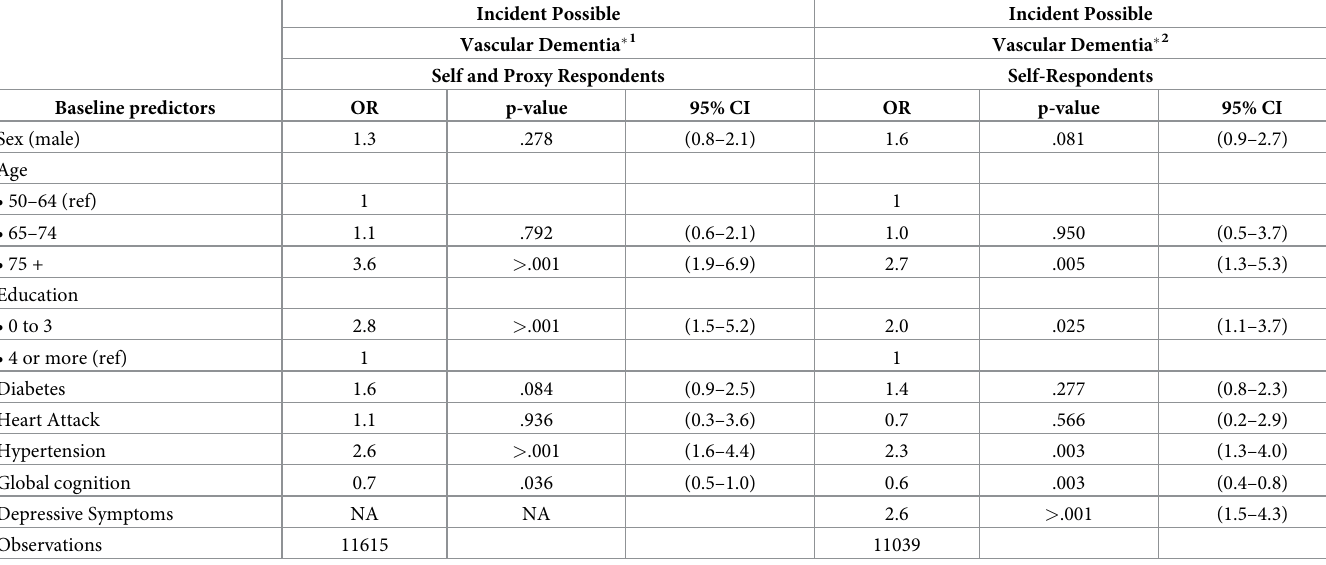
Table 4. Generalized estimation equations regression models for predictors of possible vascular dementia using